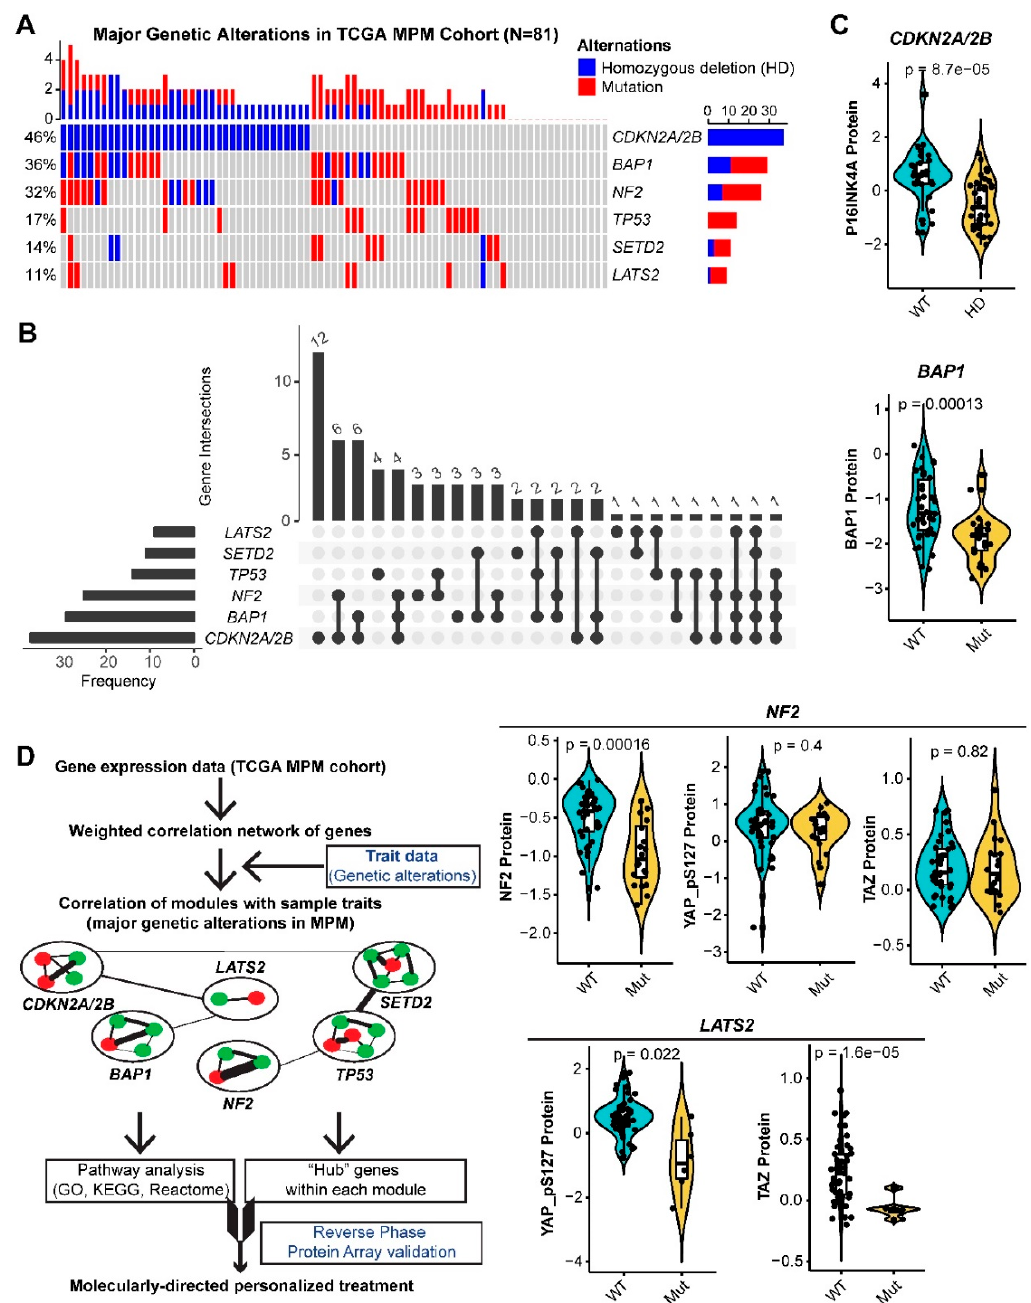
Figure 1. Major genetic alterations in The Cancer Genome Atlas (TCGA) MPM cohort. ( A , B ), ( A ) and overlap ( B ) of major ( > 10%) genetic alterations in The Cancer Genome Atlas (TCGA) malignant pleural mesothelioma (MPM) cohort ( N = 81). ( C ), the association between the major genetic alterations ( A ) and the corresponding protein level in TCGA MPM cohort ( N = 61). Protein array data were downloaded and reanalyzed from The Cancer Proteome Atlas (TCPA) database (https: // tcpaportal.org / tcpa / ). Of note, protein quantification data of LATS2 and SETD2 were not available in the TCPA database. Phospho-YAP (S127) and TAZ are two critical factors, indicating the activity